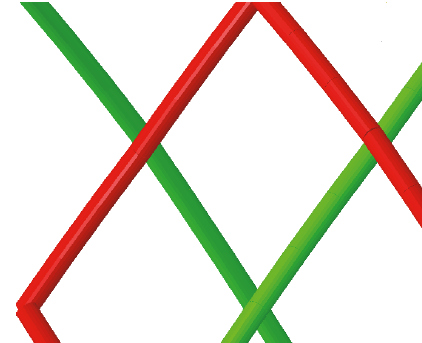
Figure 3: Contact model of braided wire (red, left-handed helical strands; green, right-handed helical